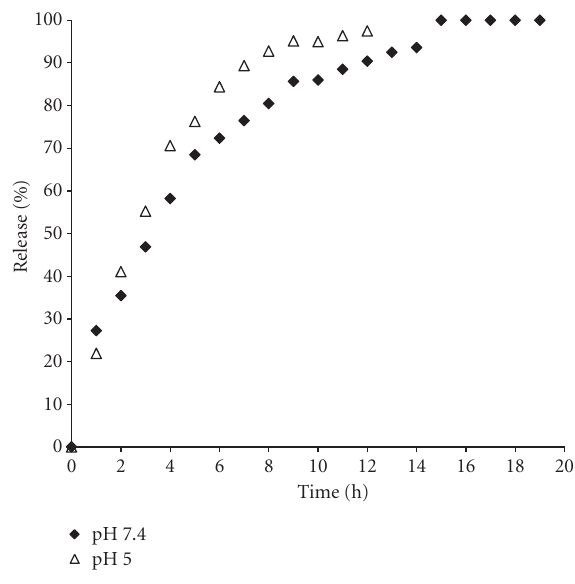
Figure 7: Release rate at pHs 7.4 and 5.0 of the hydrophobic dye Nile Red from micelles formed from copolymer 9 .